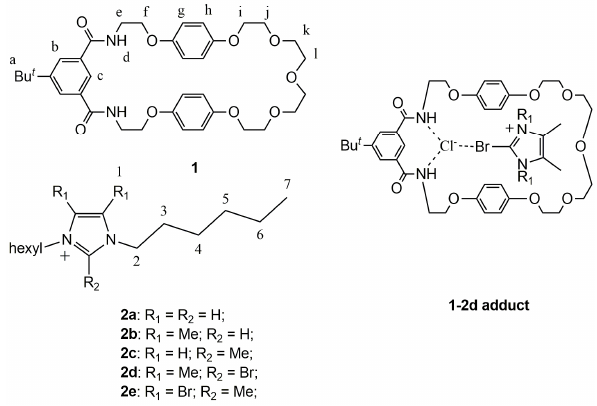
Figure 5. Numbering of the compounds studied in reference [87] and structure of the 1-2d adduct.